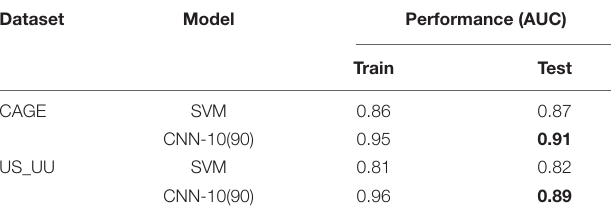
TABLE 3 | Comparison of the proposed model with SVM. Dataset Model